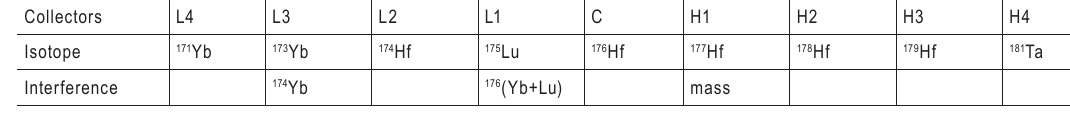
Table 2: ICP-MS faraday configuration for Lu-Hf analysis